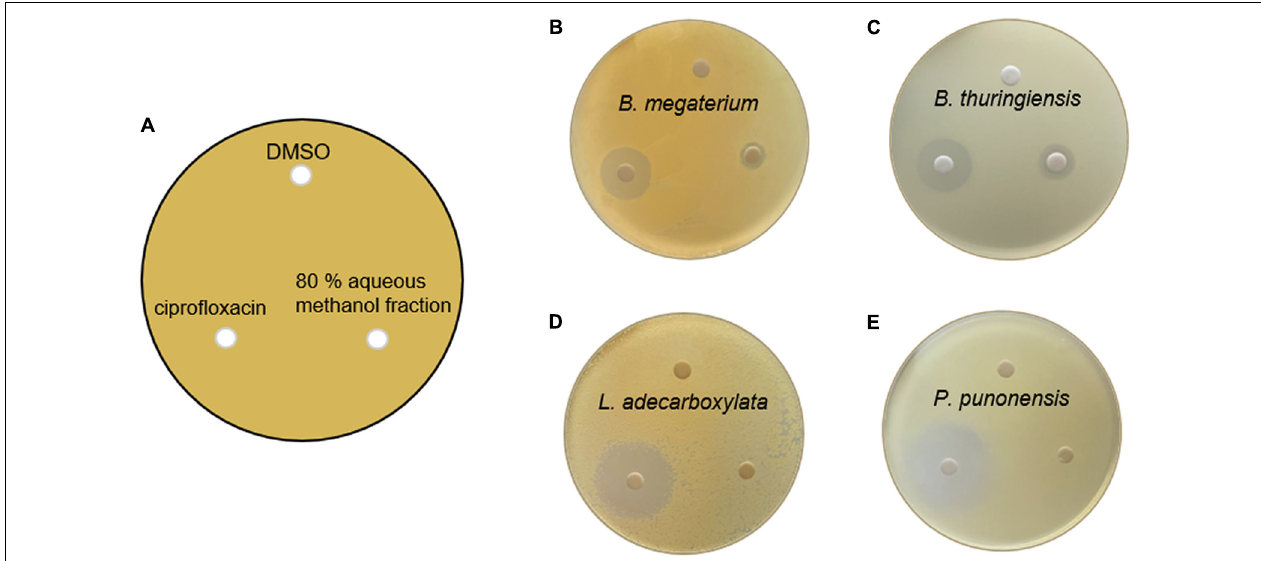
FIGURE 6 | (A) Petri plate antibacterial activity assay setup, showing that 500 µ L of the four external bacterial contaminants from the leaves of M . japonica was inoculated and spread on a K agar plate. The placement of lobophorin A and G-containing 80% methanol fraction of S. olivaceus JB1 extract dissolved in DMSO (1 mg/mL, 20 µ L), the negative control (DMSO only, 20 µ L), and the positive control ciprofloxacin dissolved in DMSO (1 mg/mL, 20 µ L) 3 days after inoculation. (B) Antimicrobial activity against Bacillus megaterium JB8; the diameter of growth inhibition of ciprofloxacin was 1.8 cm, and the fraction was 0.9 cm. (C) Bacillus thuringiensis JB9; the diameter of growth inhibition of ciprofloxacin was 1.9 cm, and the fraction was 1.5 cm. (D) Leclercia adecarboxylata JB10; the diameter of growth inhibition of ciprofloxacin was 2.5 cm, and the fraction did not show antibacterial activity against L . adecarboxylata. (E) Pseudomonas punonensis JB11; the diameter of growth inhibition of ciprofloxacin was 3.0 cm, and the fraction did not show antibacterial activity against P . punonensis